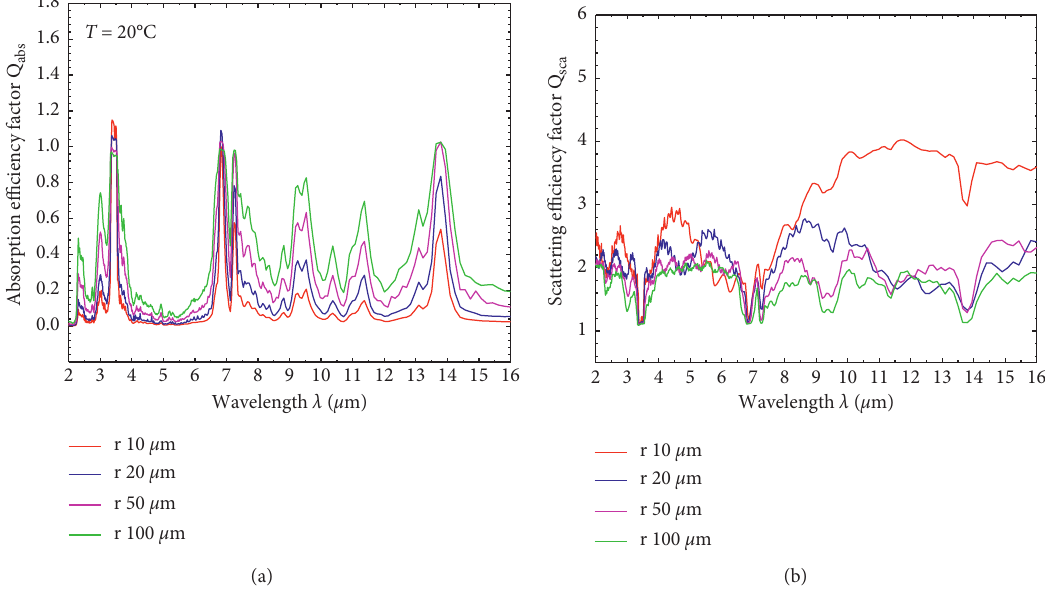
Figure 4: Absorption and scattering efficiency factors of a single spherical n-octane droplet at 20 °